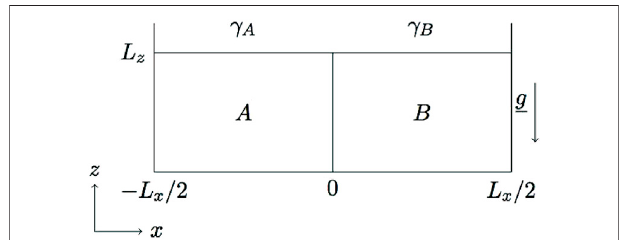
FIGURE1| Sketchofthesystem.TwoaqueoussolutionsofreactantsA and B of concentrations a 0 and b 0 and of surface tension γ A and γ B , respectively, are initially separated in space in a 2D domain of length L x and height L z . The species diffuse at rates D a and D b